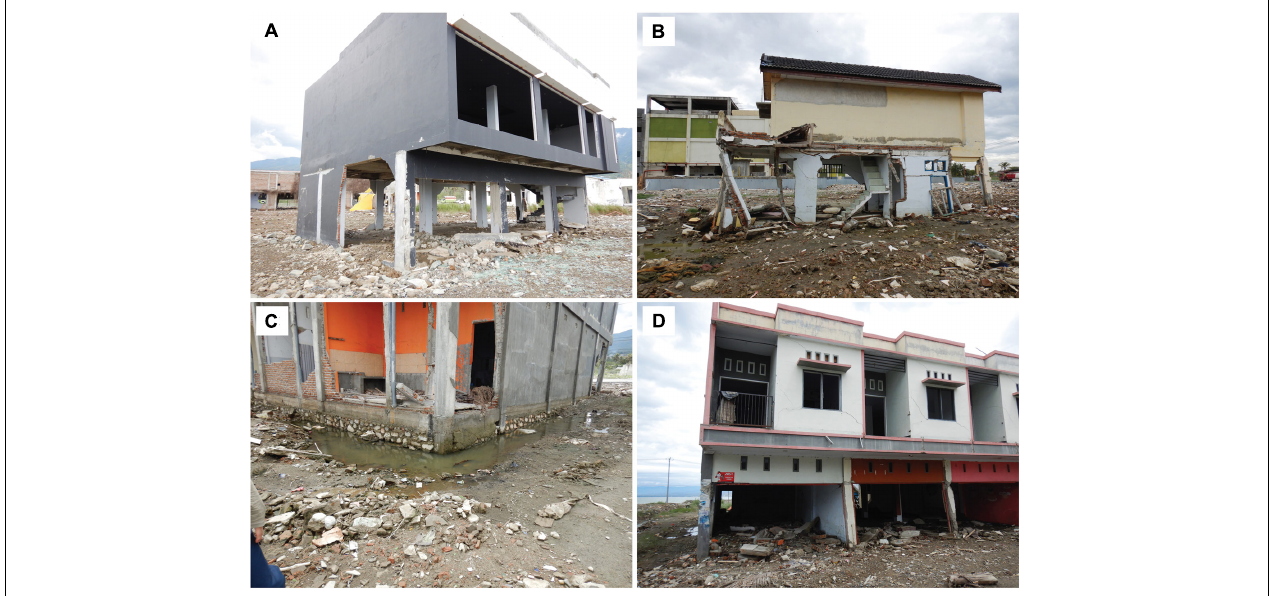
FIGURE 6 | Observed tsunami damage in the Palu Bay area (point 3 in Figure 2 ): (A,B) destroyed 2-story buildings, (C) souring damage, and (D) tilted building complex.